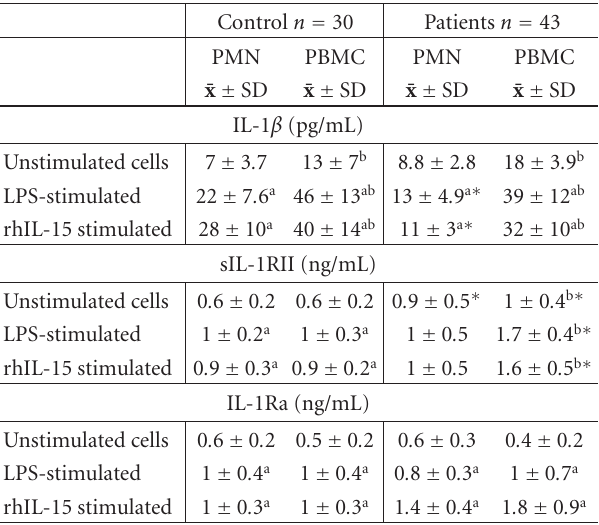
∗ Statistical di ff erences between control and patients groups ( P < . 001) . a Statistical di ff erences between unstimulated cells and cells incubated with LPS or rhIL-15 ( P < . 001) . b Statistical di ff erences between PMN and PBMC ( P < . 001) .